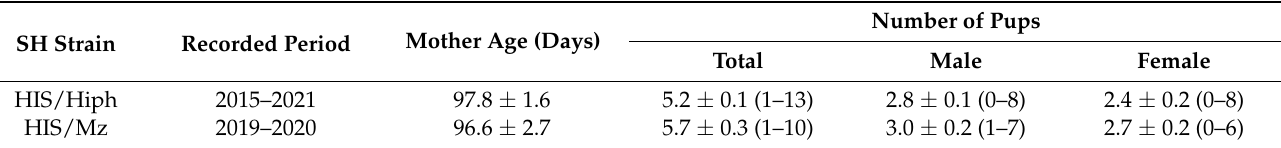
Table 1. The number of pups recorded in the inbred SH strains, HIS/Hiph and HIS/Mz.